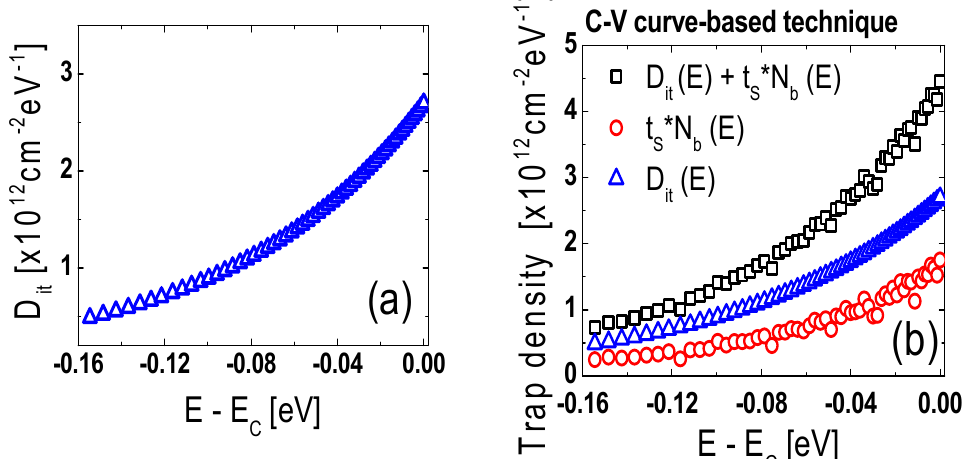
Figure 6. ( a ) Energy distribution of the density of interface trap states D it obtained using the technique based on the C – V curve. ( b ) Energy distributions of the total subgap DOS D it + t S × N b , D it , and the density of bulk trap components t S × N b obtained using the technique based on the low-frequency C – V curve.